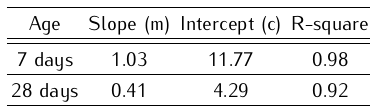
Table 5. Coefficient of the linear relationships between permeability versus